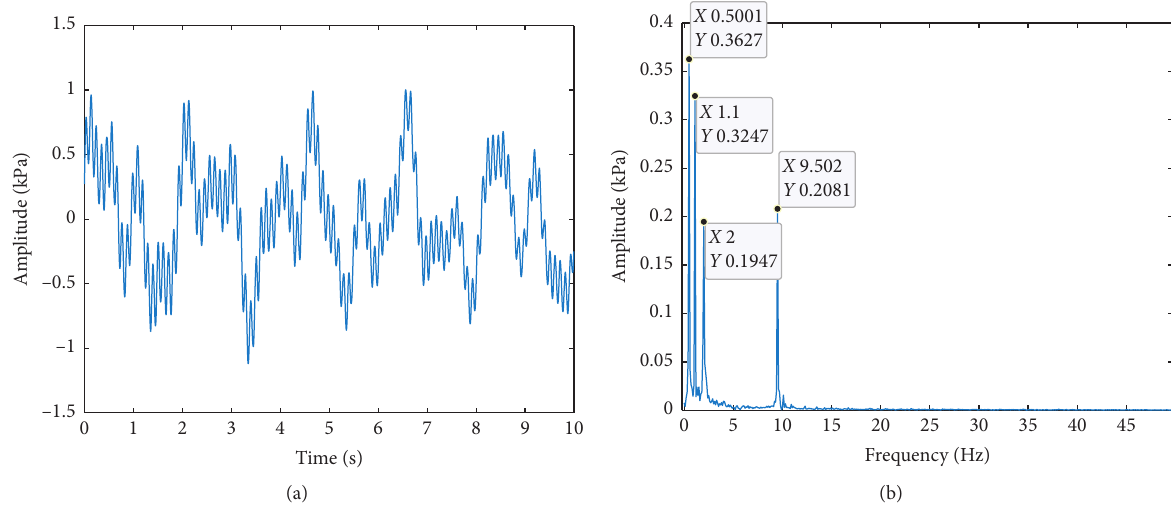
Figure 6: Waveform and spectrum diagram after EMD-SVD noise reduction. (a) Waveform diagram. (b)